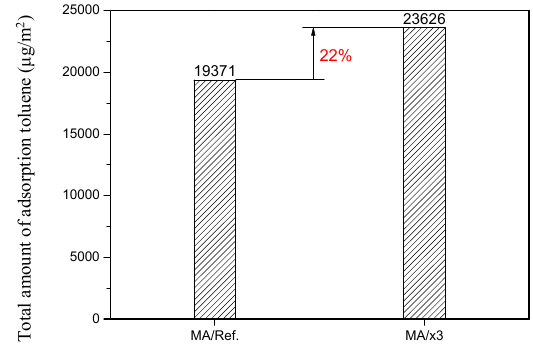
Figure 9. Total amount of adsorption toluene.